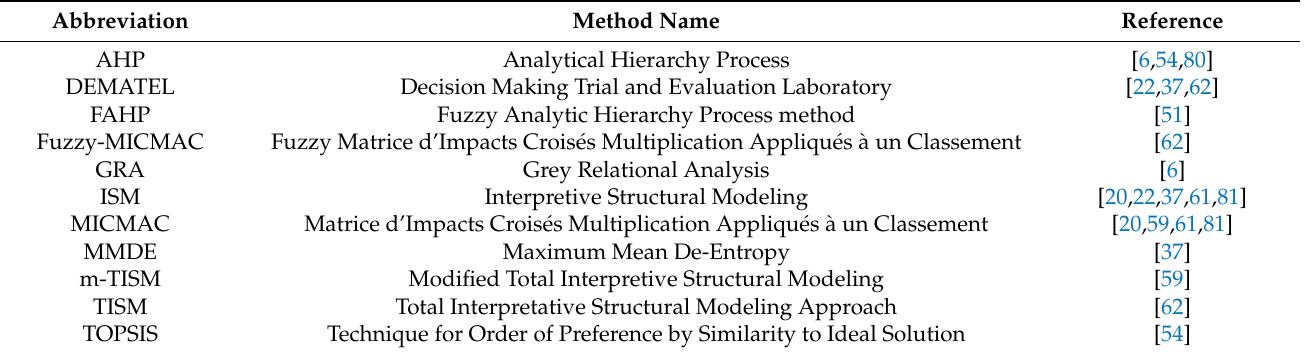
Table 4. Multicriteria decision-making methods are used in determining IoT adoption